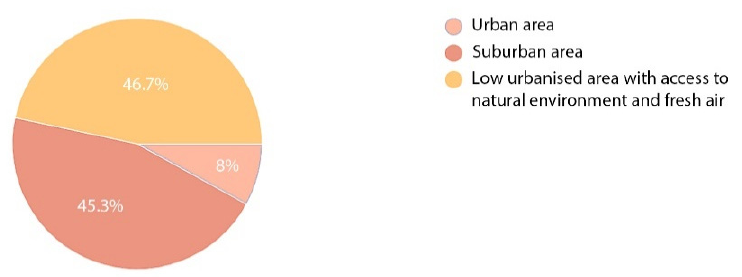
Figure 16. Preferred location of a hospital—patients .